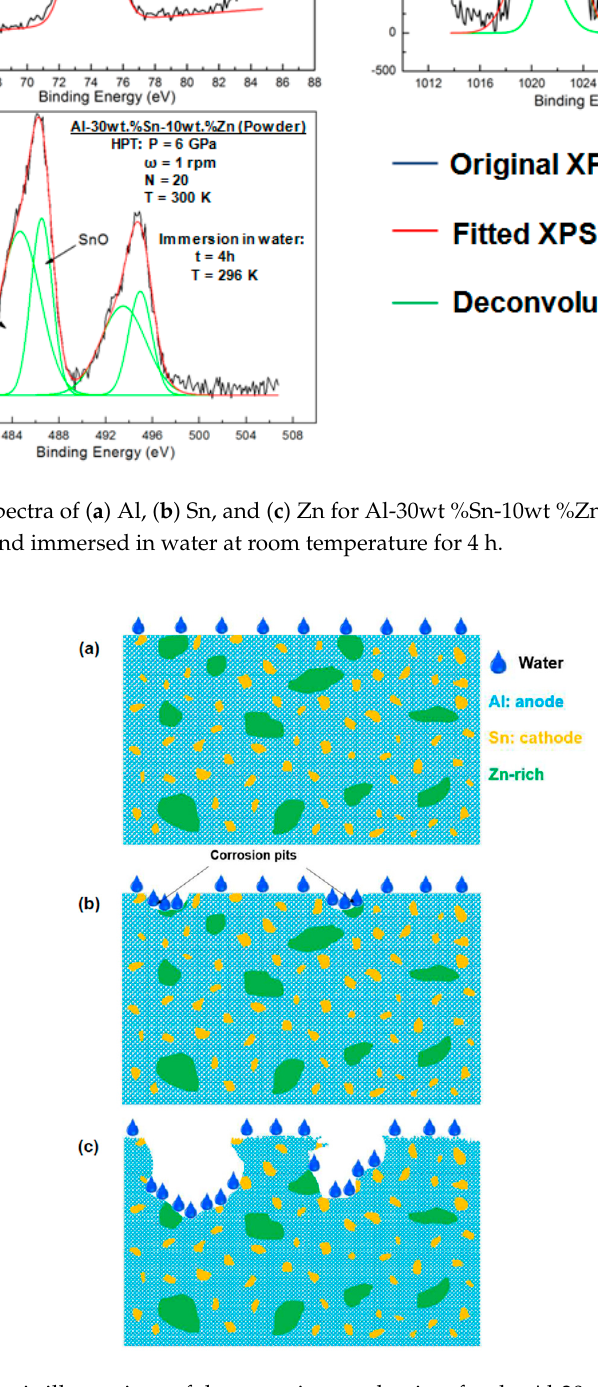
Figure 15. Schematic illustrations of the corrosion mechanism for the Al-30wt %Sn-10wt %Zn alloy: ( a ) immediately after immersion, ( b ) initiation of corrosion pits, and ( c ) propagation of corrosion .